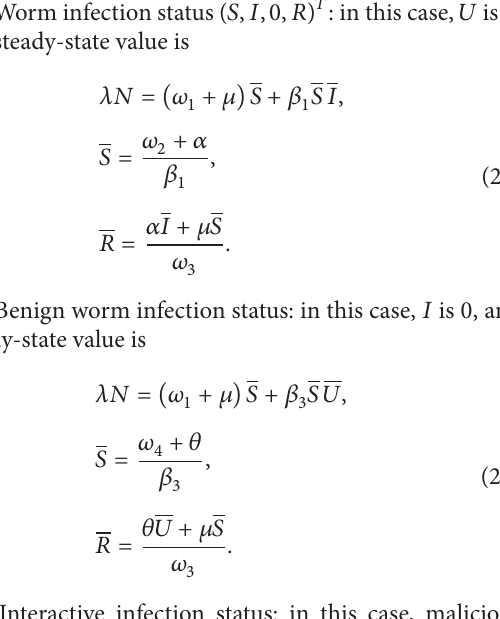
benign worm propagation curve. The 𝑥 axis represents the time (one hour per unit), and the 𝑦 axis represents the number of infectious population 𝐼(𝑡) and benignly infectious population for a dashed line 𝑈(𝑡)